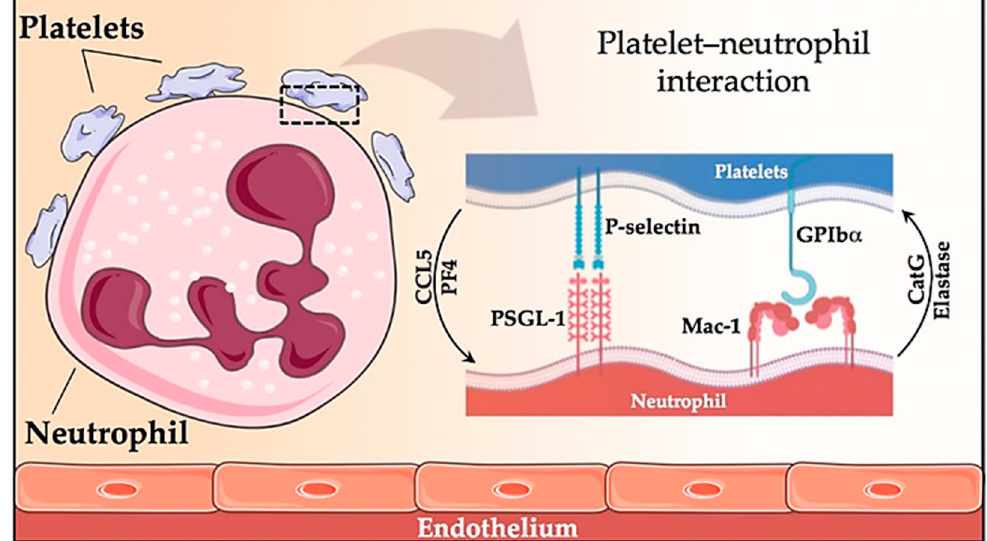
Figure 1. Platelet-neutrophil interaction. Representation of the two major receptor-ligand interactions in platelet-neutrophil communication, involving the P-selectin-PSGL1 and GPIb α -Mac-1 pairs; as well as the pathways by which platelets enhance leukocyte activation (by release of CCL5 and PF4) and vice versa (platelets are activated by release of elastase and cathepsin G from neutrophils).